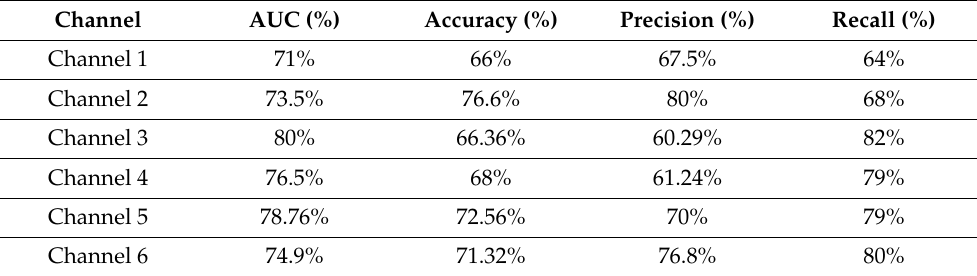
Table 5. Accuracy, area under curve (AUC), precision and recall results for model 2, 8 min